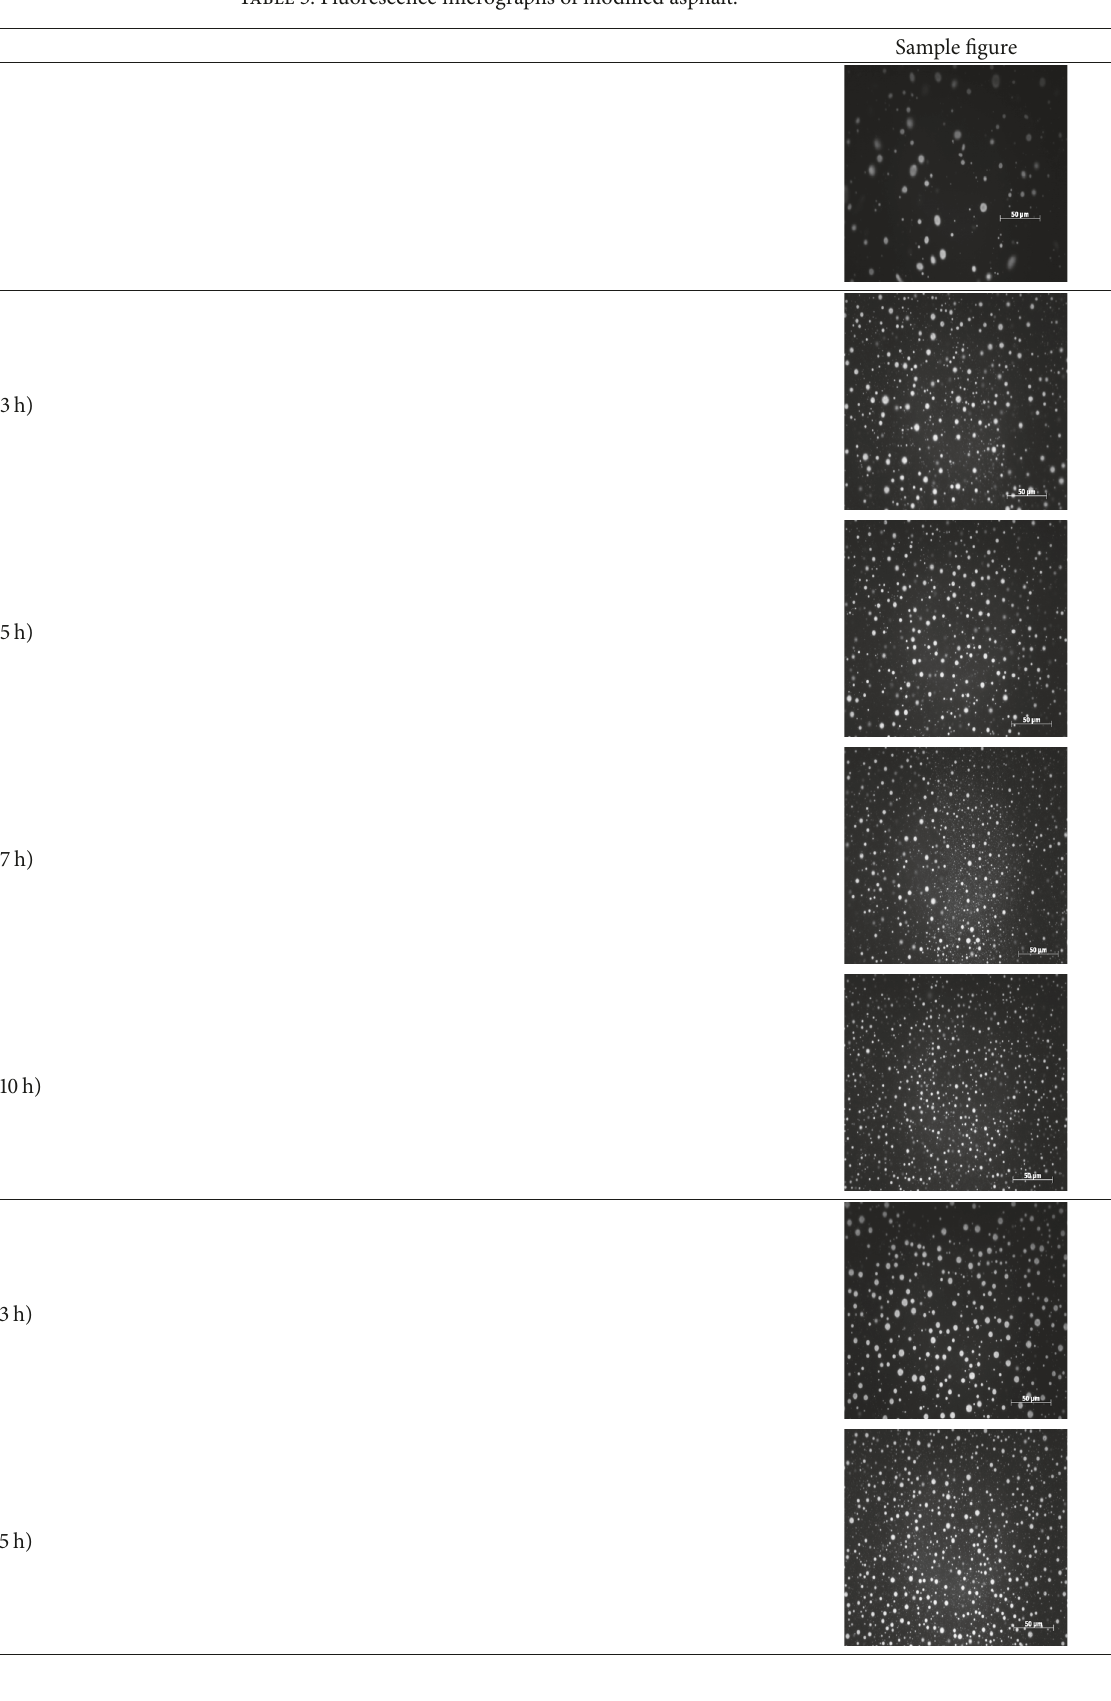
Table 5: Fluorescence micrographs of modified